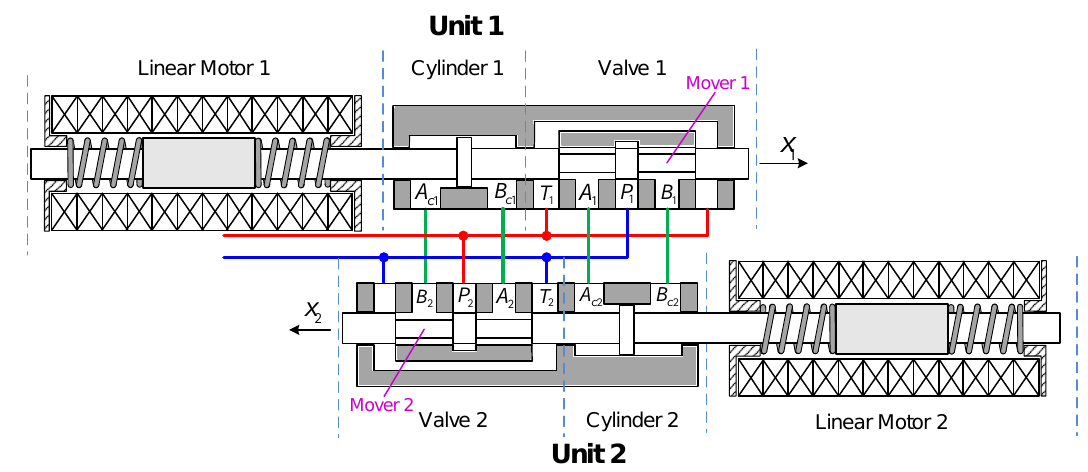
Figure 1. Schematic structure of the linear drive collaborative rectification structure pump